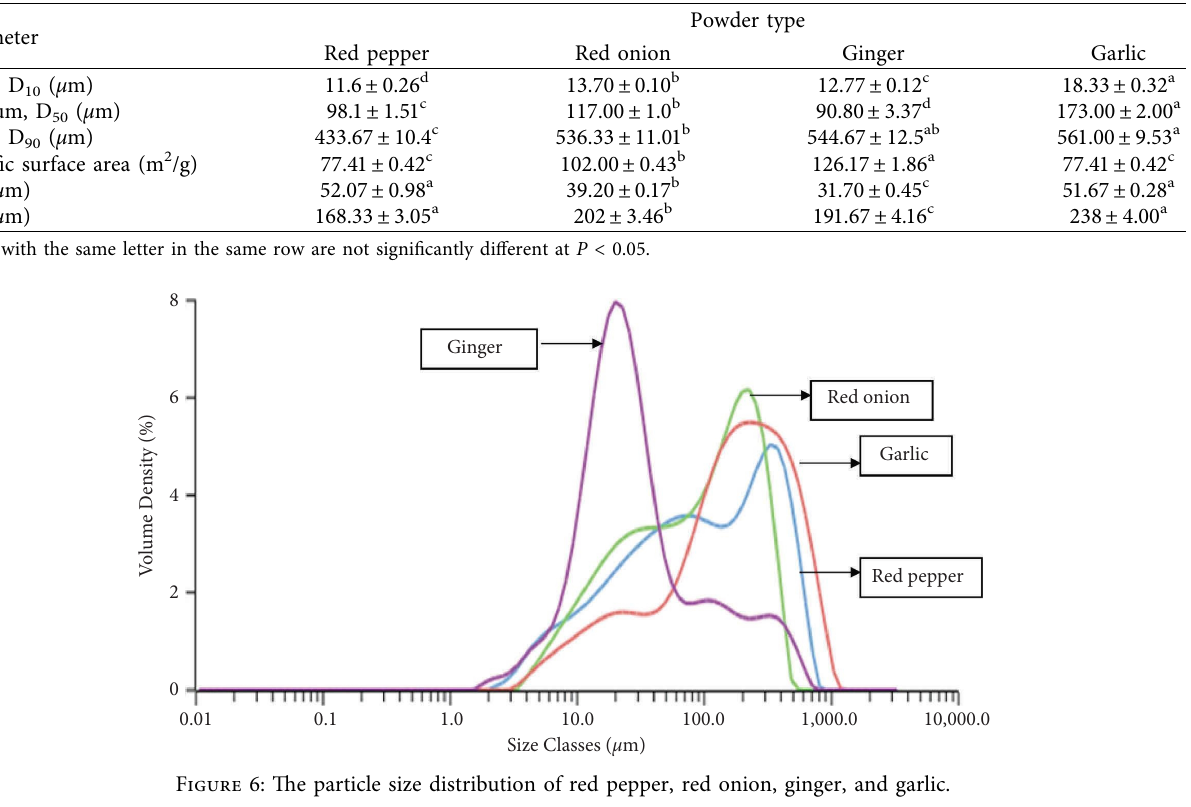
Table 4: Particle size distribution and specifc surface area.